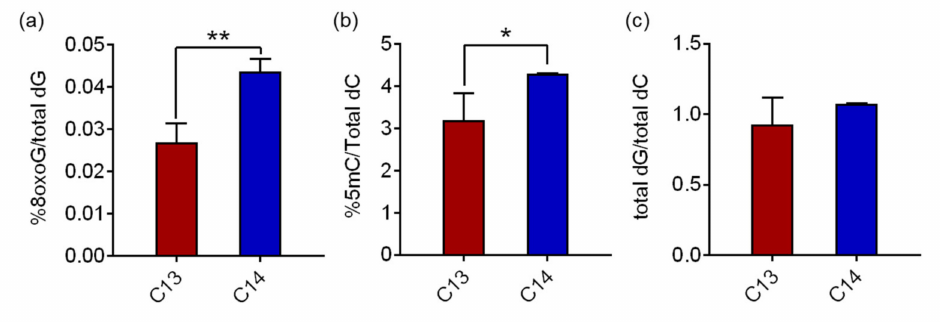
Figure 2. Significant increased levels of 8-oxoG in C14 sperm DNA. ( a ) Comparison of 8-oxoG levels in C13 and C14 sperm DNA. Total dG is the sum of 8-oxoG and dG. ( b ) Comparison of 5mC in C13 and C14 sperm DNA. Total dC is the sum of 5mC and dC. ( c ) The ratio of total dG and total dC. Bars indicate the average value of technical triplicate ± SD. * p < 0.05, ** p < 0.01 vs.